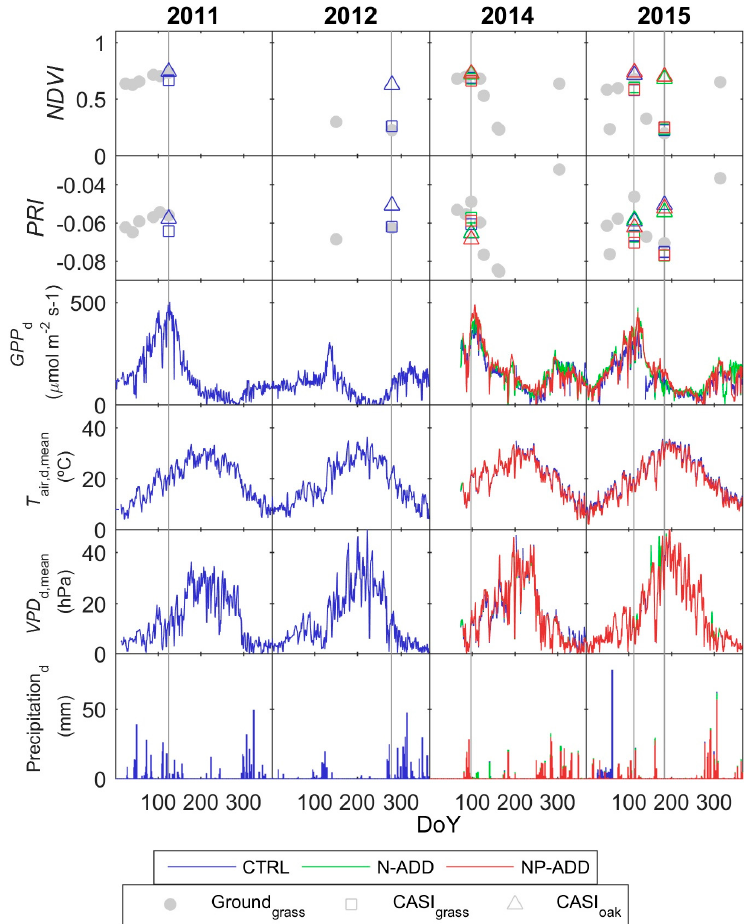
Figure 3. Optical (spectral vegetation indices), flux (daily accumulated GPP ) and meteorological (daily mean air temperature ( T air ), vapor pressure deficit ( VPD ) and daily accumulated